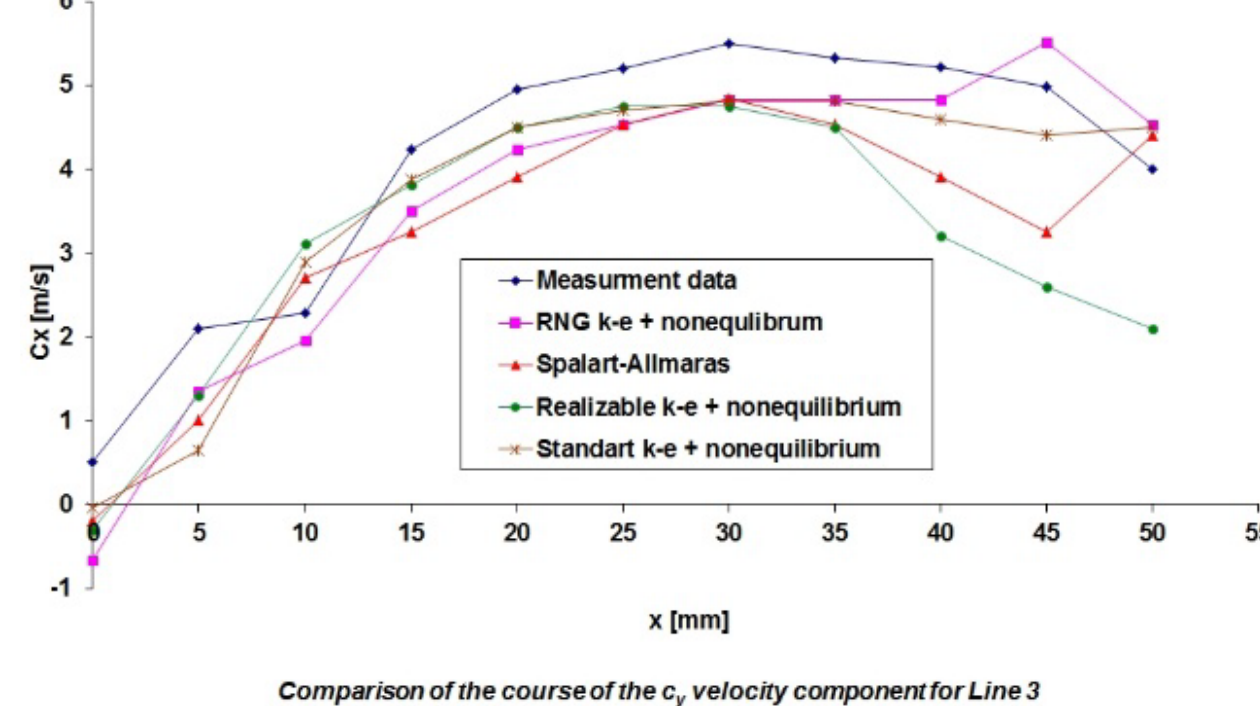
Figure 14. Comparison of the course of the cx, cy velocity components for Line 2.